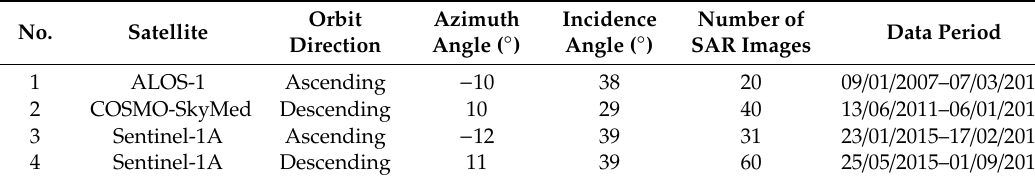
Table 1. Parameters of synthetic aperture radar (SAR) data in this